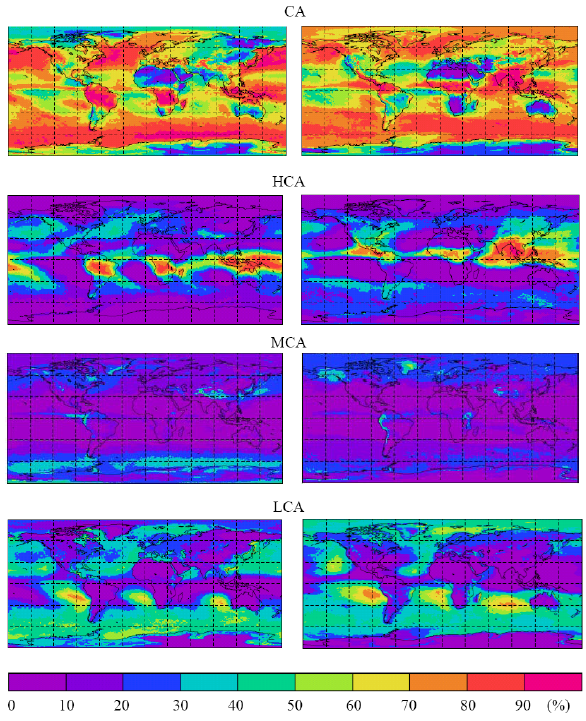
Figure 6: Geographical maps of total, high, midlevel and low cloud amount from AIRS-LMD, in Fig. 6. Geographical maps of total, high, midlevel and low cloud January (left) and in July (right). Averages over the period from 2003 to 2008. amount from AIRS-LMD, in January (left) and in July (right). Av- erages over the period from 2003 to 2008.